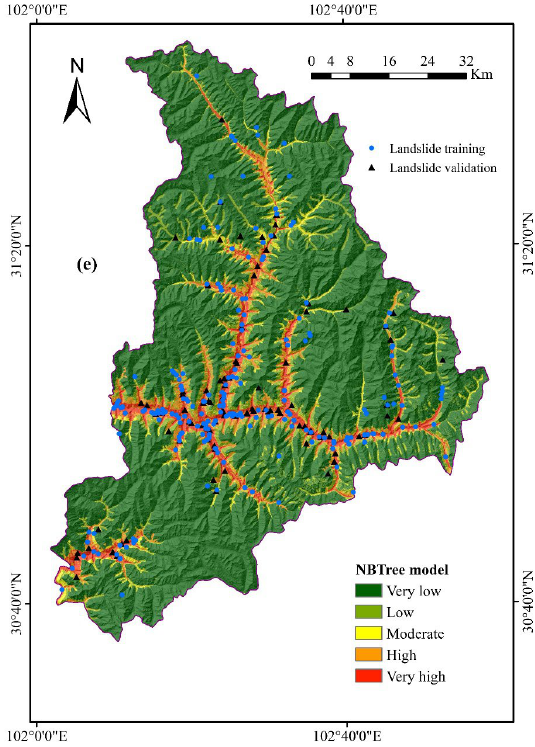
Figure 7. Landslide susceptibility maps: ( a ) FT model, ( b ) RSFT model, ( c ) BFT model, ( d ) CART model, ( e ) NBTree model.